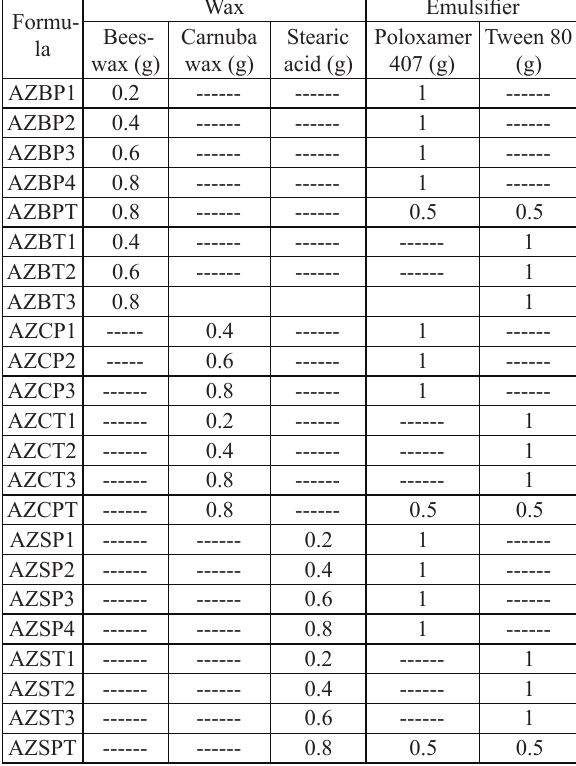
Formulations of microparticles